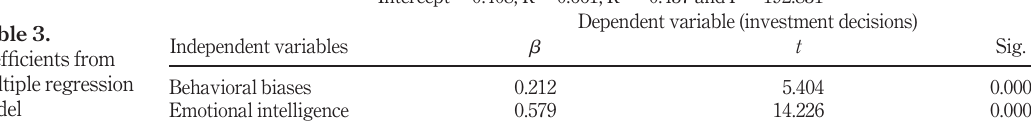
Table 3. Coef fi cients from multiple regression